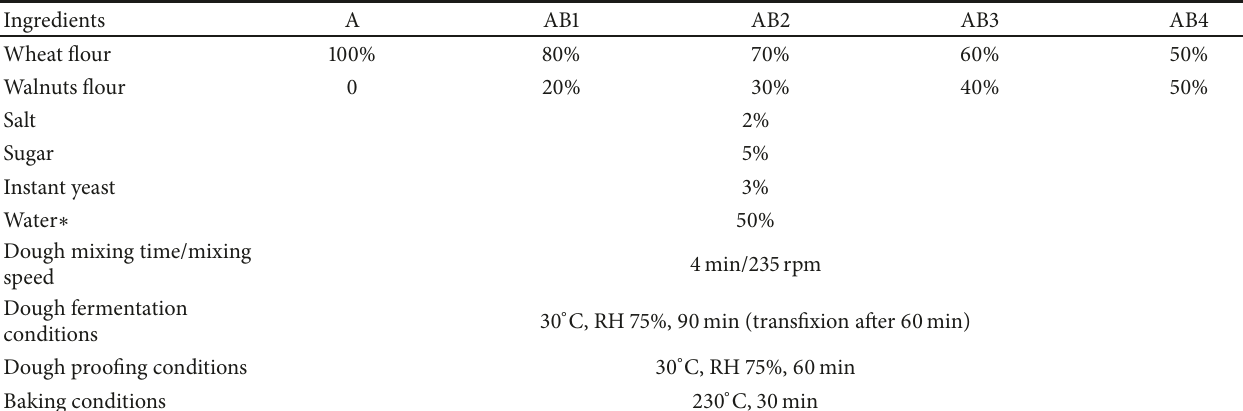
Table 1: Bread making